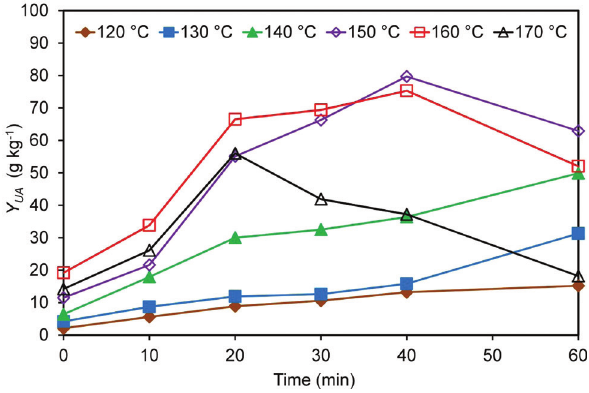
Figure 2: Effect of reaction temperature and holding time on the yield of uronic acids.